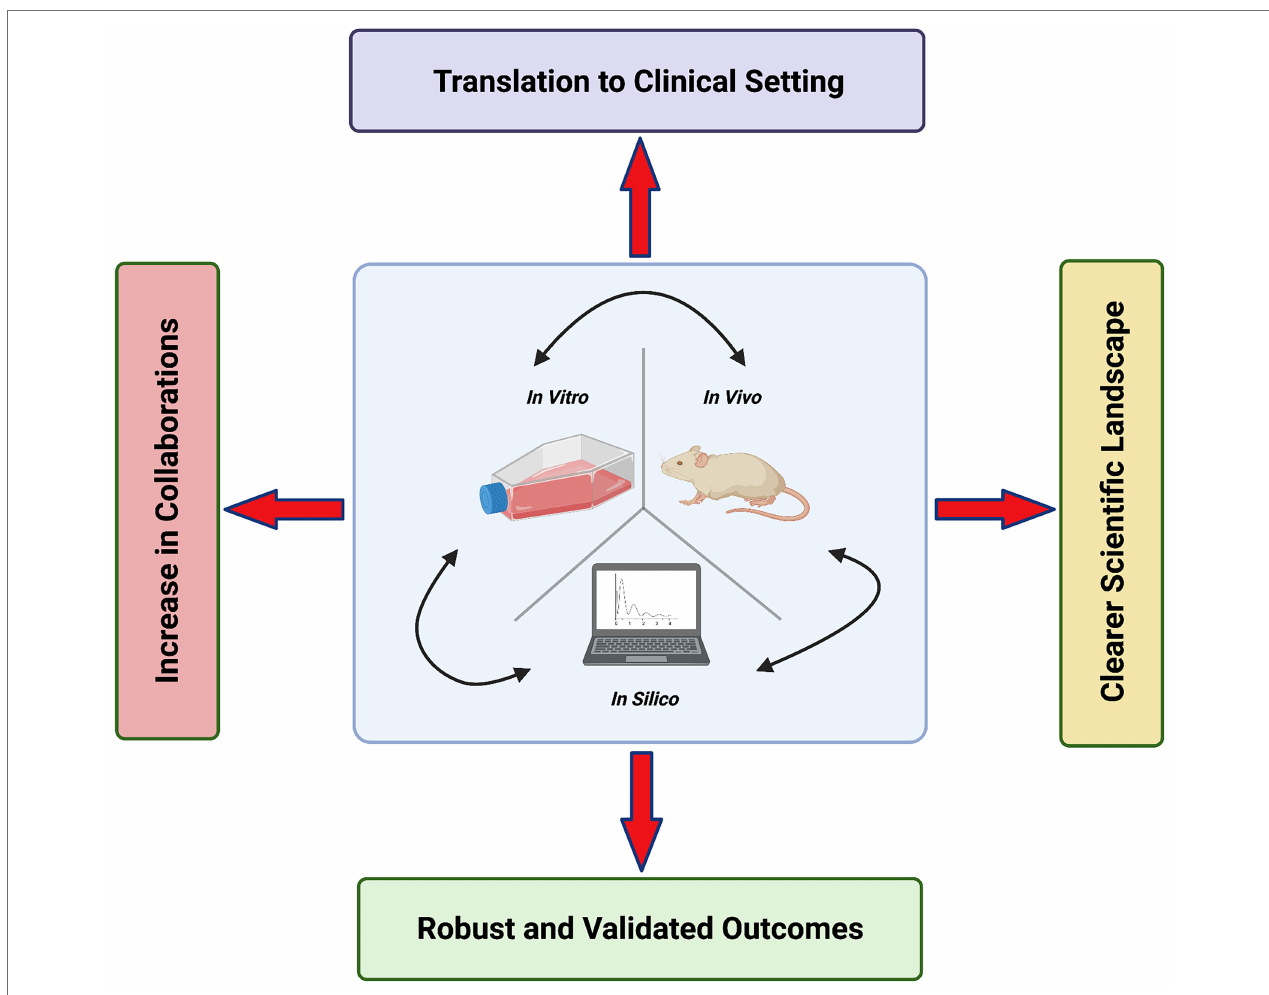
FIGURE 3 | The benefits of a “Team Science” approach in cardiac arrhythmia and heart failure research. Created with